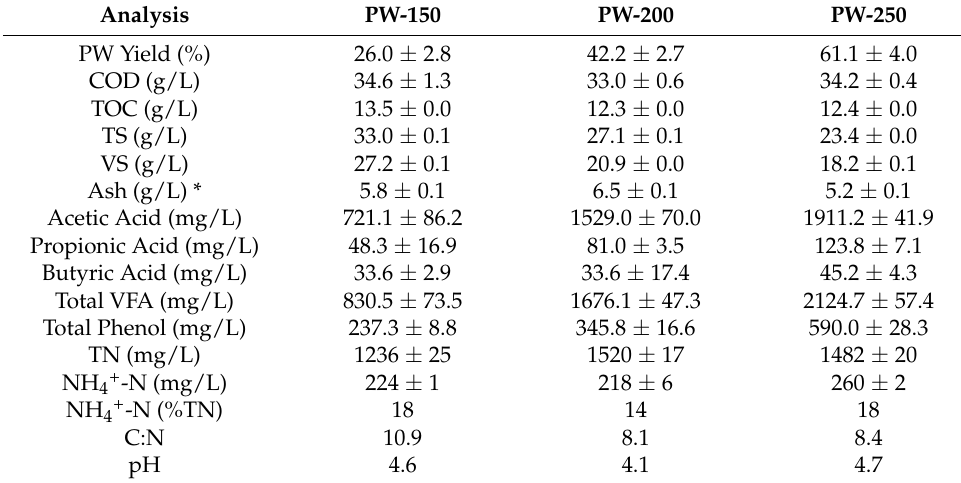
Table 5. Composition of HTC process